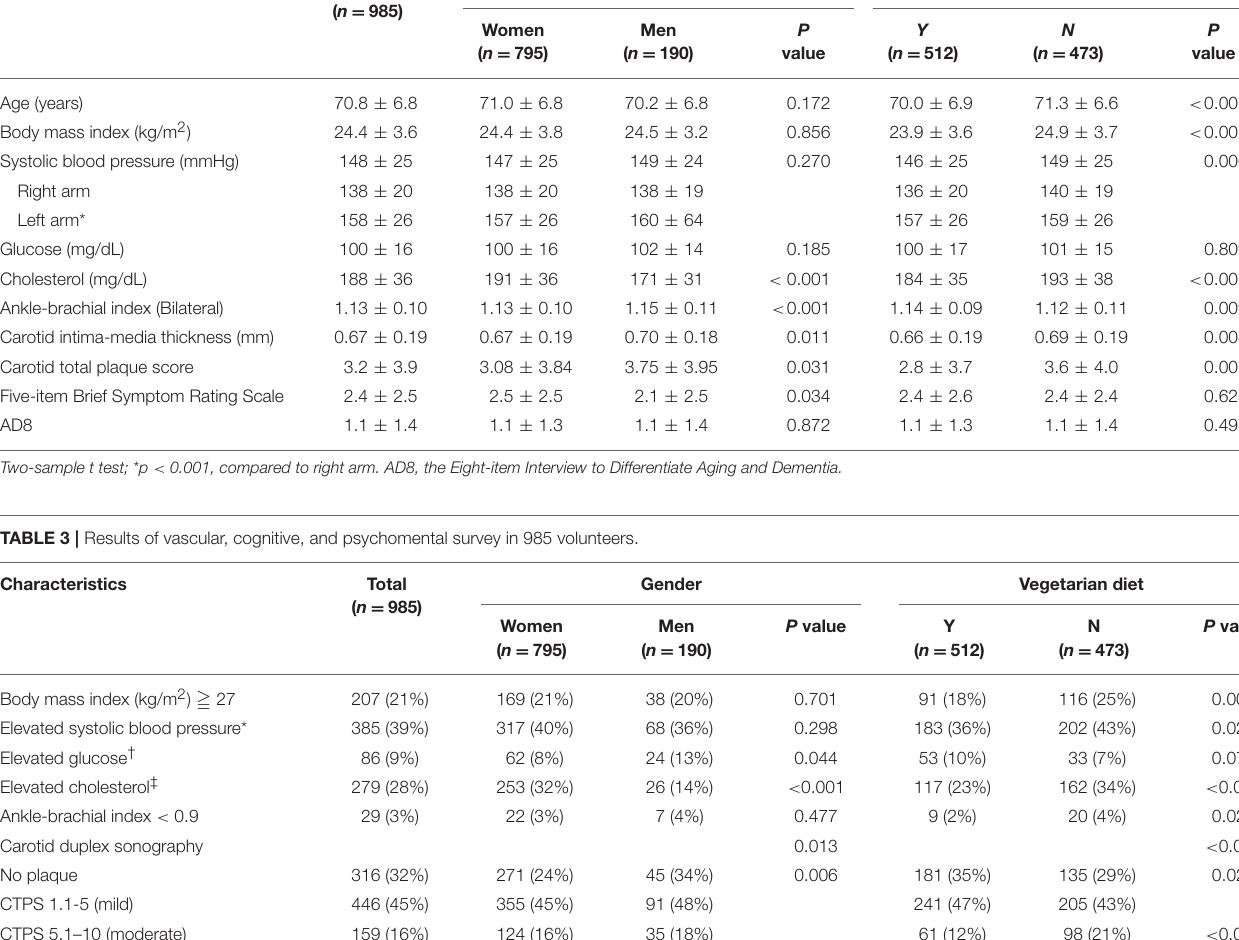
TABLE 2 | Results of measured variables during health examination in 985 volunteers. Characteristics